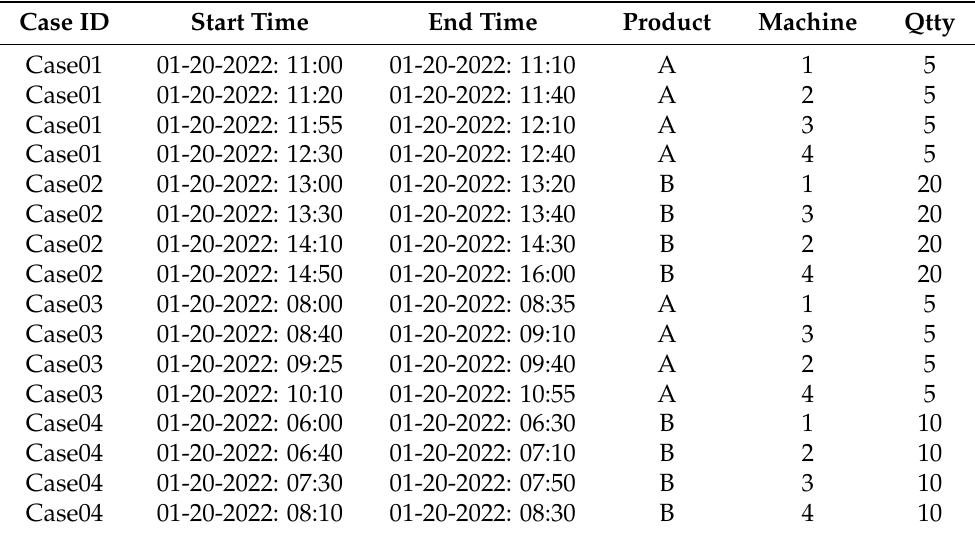
Table 1. Example of an